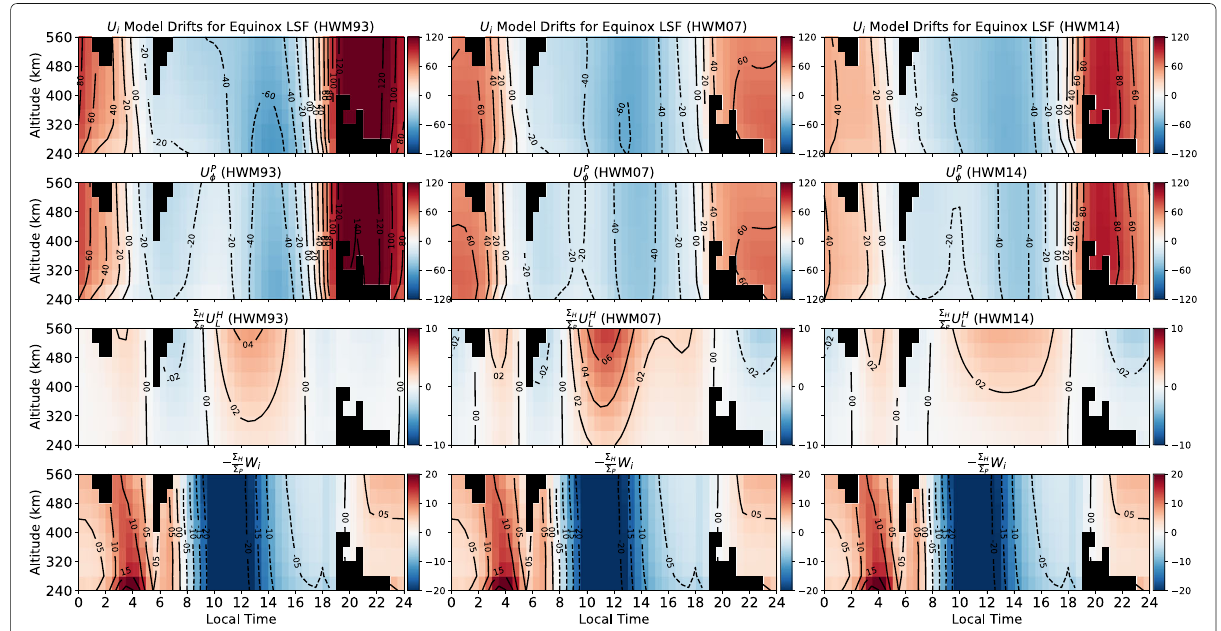
Fig. 10 The contribution of each term of Eq. 6 to the modeled zonal drifts. Equinox low solar flux (LSF) conditions